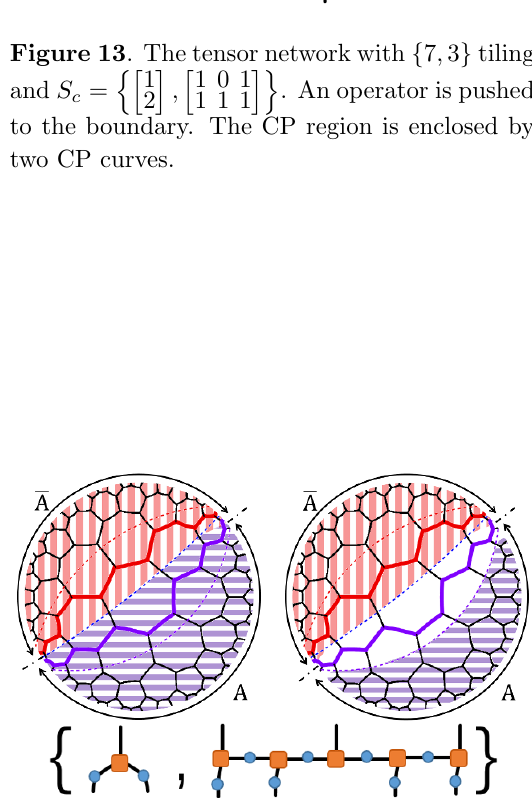
Figure 14 . The tensor network with f 7 ; 3 g tiling nh 1 io and S c = . 2